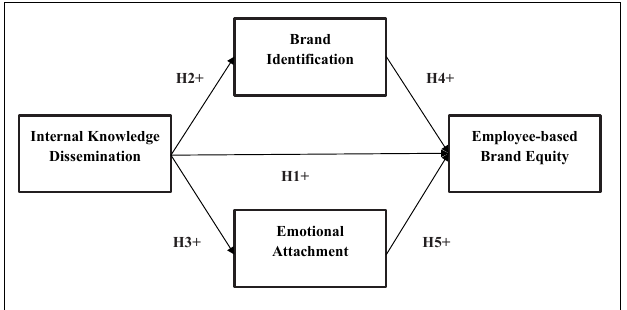
FIGURE 1 | Conceptual